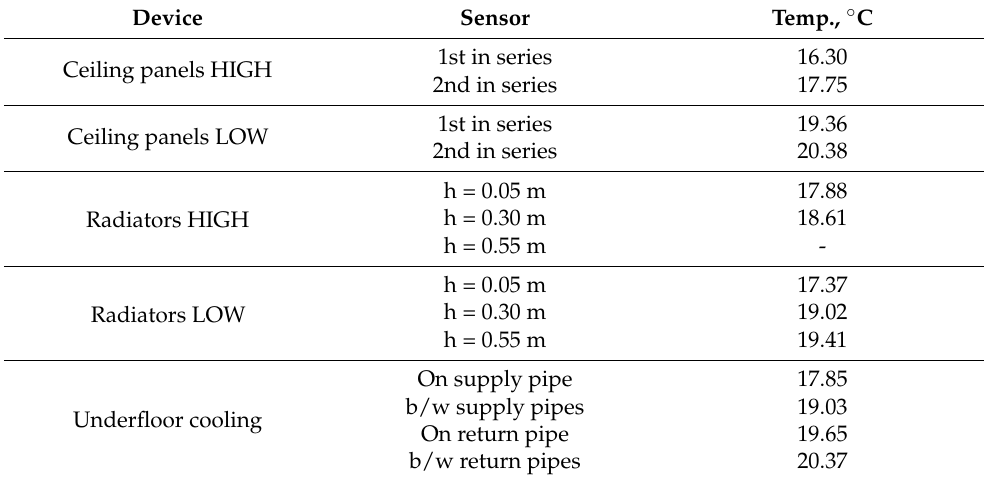
Table 7. Surface temperatures as measured with sensors.